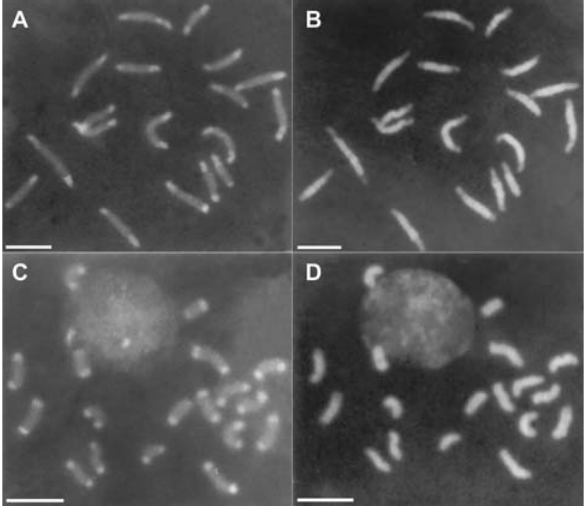
Figure 2 - Sequential staining with CMA 3 /DA/DAPI in metaphases of Melipona rufiventris (A: CMA 3 ; B: DAPI) and M. mondury (C: CMA 3 ; D: DAPI). Scale bar = 5 μ m.